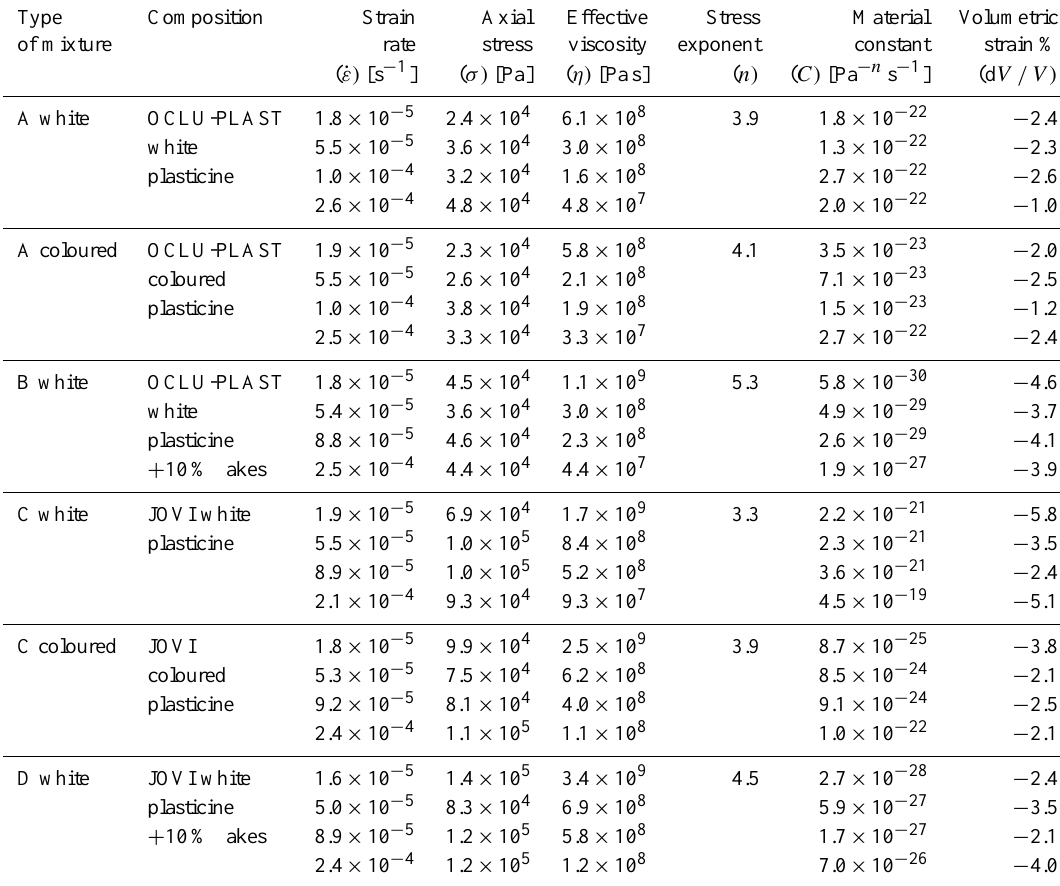
Table 1. Properties calculated from compression tests for the different mixtures used as rock analogues. The values of axial stress, dynamic effective viscosity, stress exponent and material constant were calculated for 10% shortening.